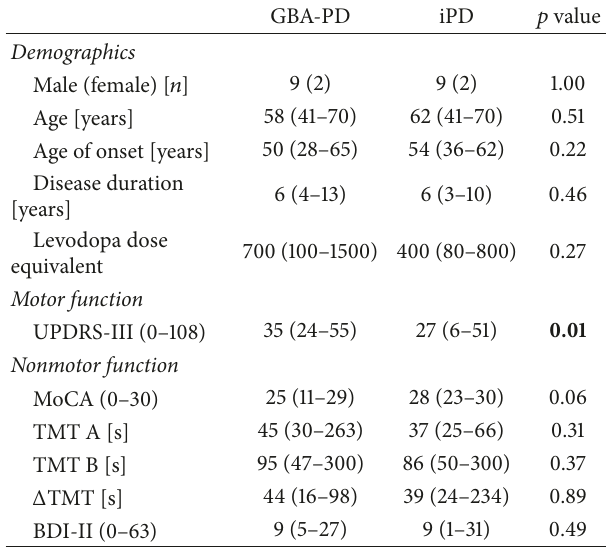
Table 1: Demographics and clinical